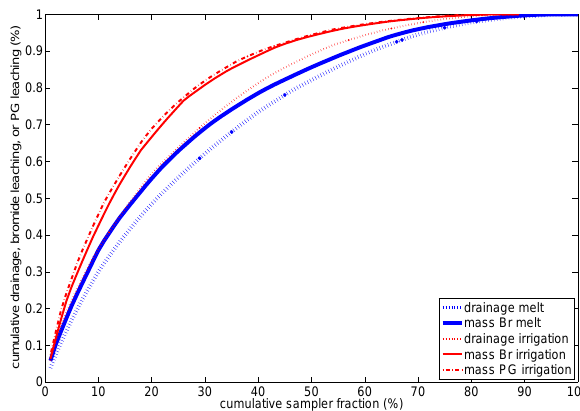
Fig.12. Normalizedcumulativedrainageandleachingofbromideduringthesnowmeltandirrigationexperi- Fig. 12. Normalised cumulative drainage and leaching of bromide ments,andPGduringtheirrigationexperiment. Thedrainageandtheleachingpercellwerescaledwiththe totaldrainageorthetotalleachedmassforthesamplerduringeitherthesnowmeltexperimentortheirrigation during the snowmelt and irrigation experiments, and PG during the experiment.Thecellsaresortedwithdecreasingamountofdrainage,bromide,orPGleaching. irrigation experiment. The drainage and the leaching per cell were scaled with the total drainage or the total leached mass for the sam- pler during either the snowmelt experiment or the irrigation experi- ment. The cells are sorted with decreasing amount of drainage, bro- mide, or PG 24